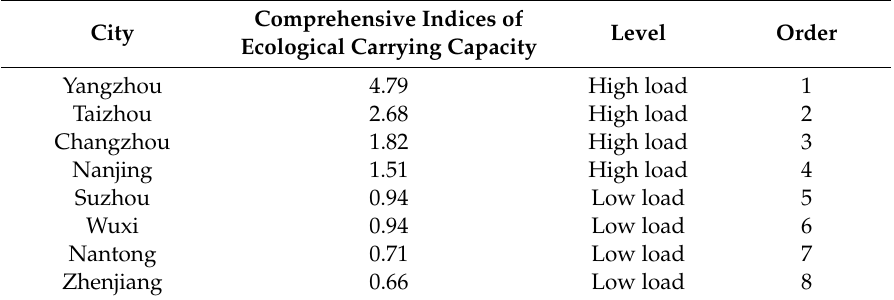
Table 4. Comprehensive indices and ranking table of ecological carrying capacity.